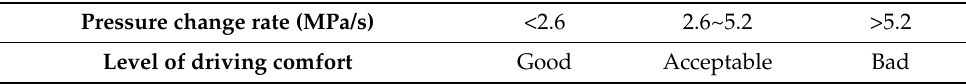
Table 2. Pressure change rate criteria for driving